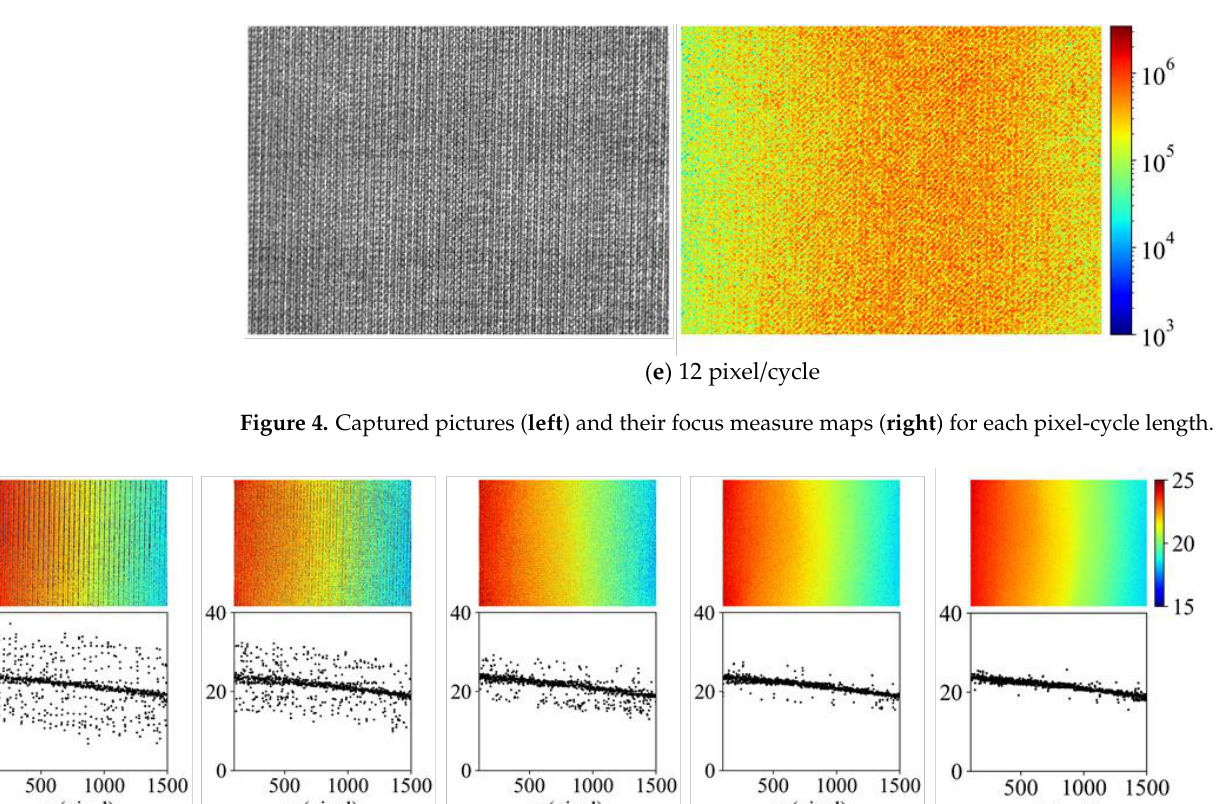
Figure 4. Captured pictures ( left ) and their focus measure maps ( right ) for each pixel-cycle length.